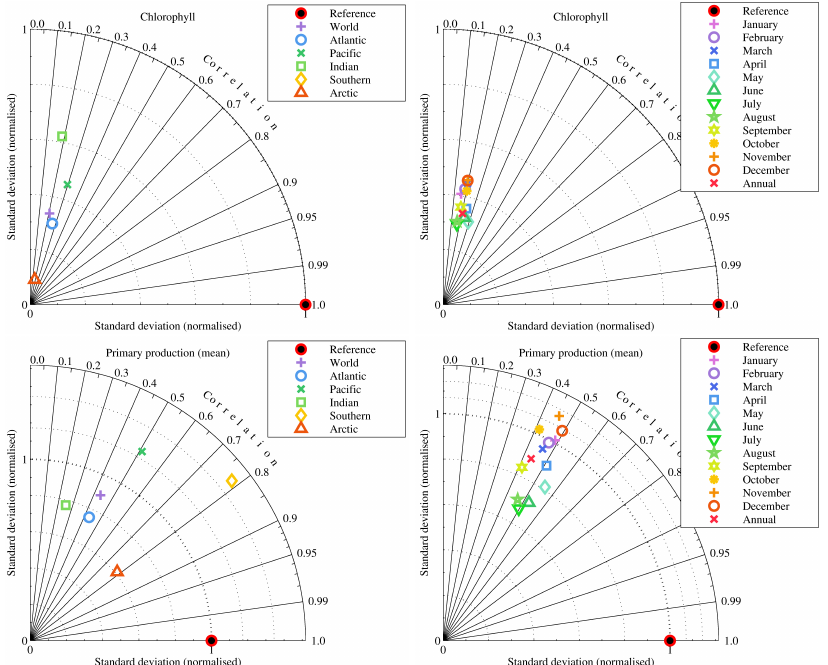
Fig. 15. Taylor diagrams of spatial (left) and temporal (right) model-observation comparisons for surface chlorophyll (top) and integrated primary production (bottom). In the leftmost panels, simulated annual means for different regions are compared to corresponding observational fields. In the rightmost panels, simulated global average means for different months are compared to corresponding observational fields.